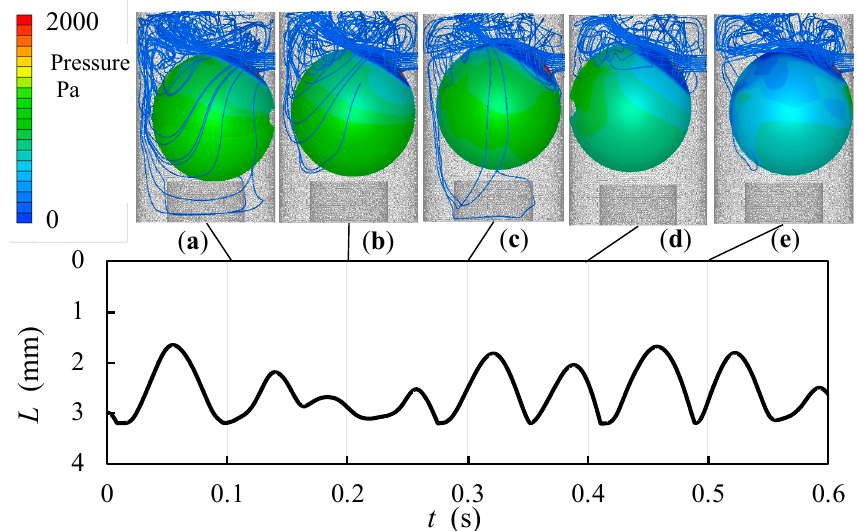
Figure 6. Time variation of lift in low-viscosity case with three degrees of freedom of Model (a): Streamlines and ball surface pressure distribution ( a ) 0.1 s, ( b ) 0.2 s, ( c ) 0.3 s, ( d ) 0.4 s, ( e ) 0.5 s.